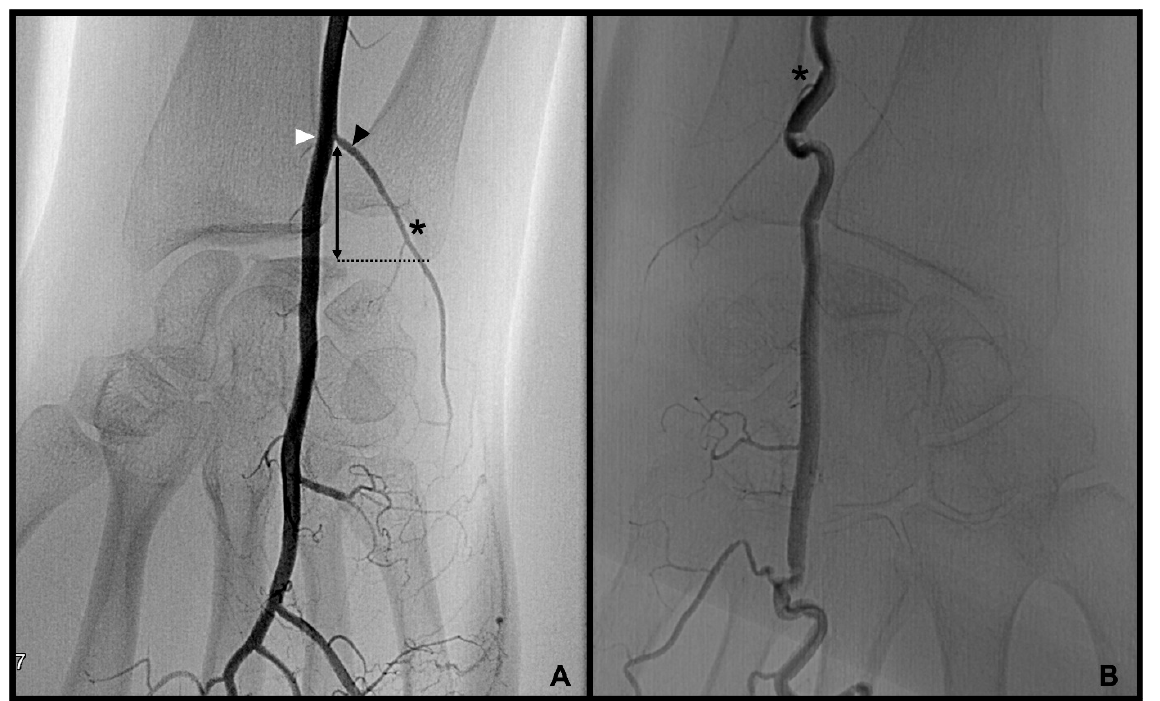
Figure 3. Palmo-dorsal superselective angiographies of the ulnar artery with a strong DCBUA ( A ) and a delicate DCBUA ( B ). * DCBUA, (cid:78) maximum diameter of the DCBUA, (cid:52) diameter of the ulnar artery at the point of rami fi cation, distance from the DCBUA to the styloid process of the ulnar (DCBUA = dorsal carpal branch of the ulnar artery).